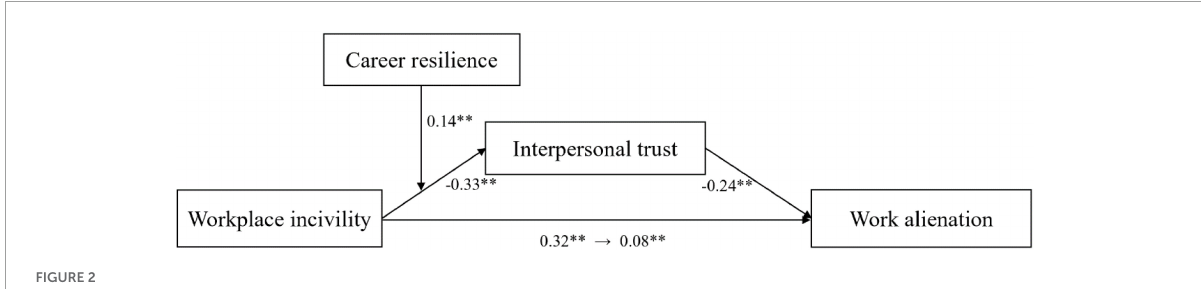
FIGURE2 The moderated mediation model. * p < 0.05; ** p < 0.01.